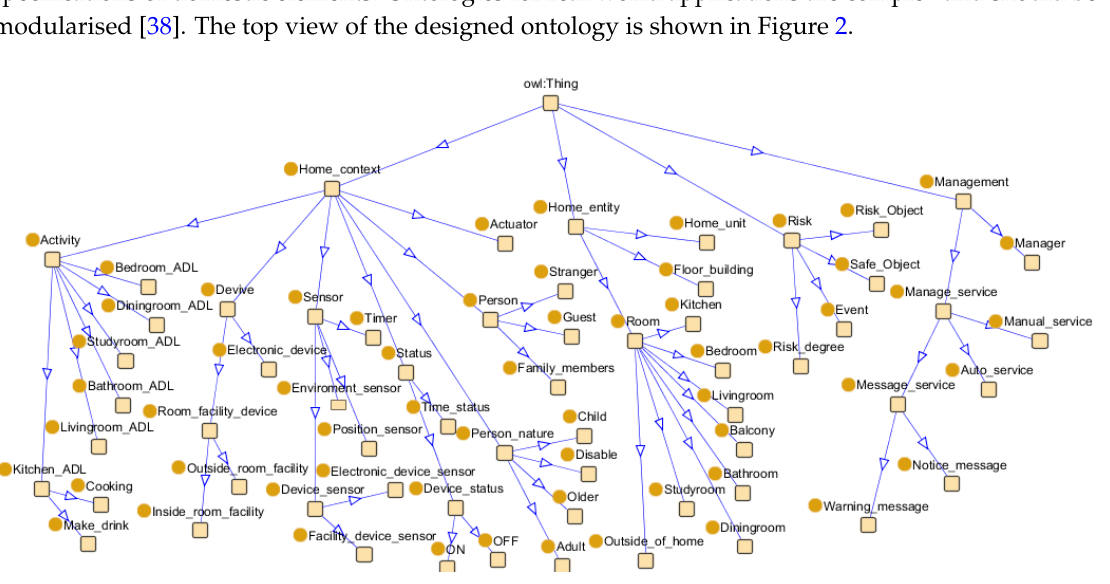
Figure 2. Top-level view of SH management ontology.